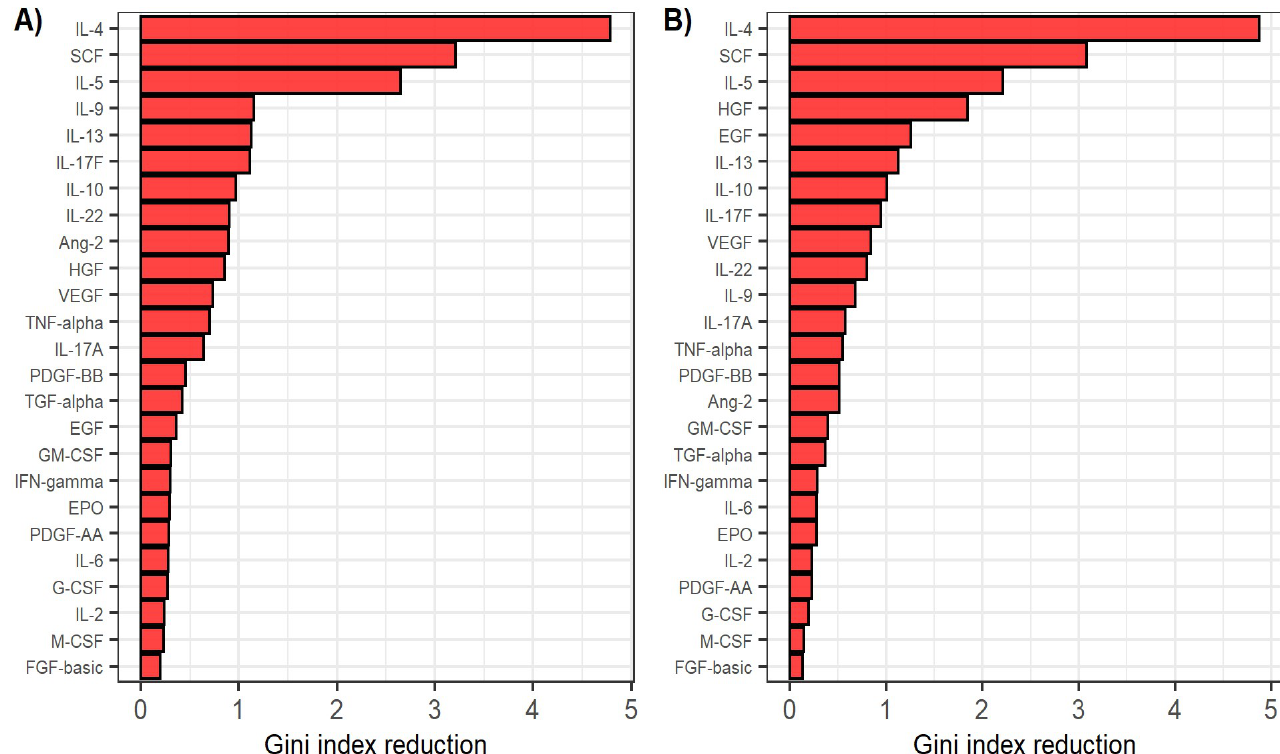
Figure 3. ( A ) Relative variable importance in classifying patients before antiviral treatment and healthy individuals by the random forest classifier. ( B ) Relative variable importance in classifying patients after reaching sustained virological response and healthy individuals by the random forest classifier. Variable importance is defined as the mean decrease in Gini coefficient when using the respective predictor in separating the groups.